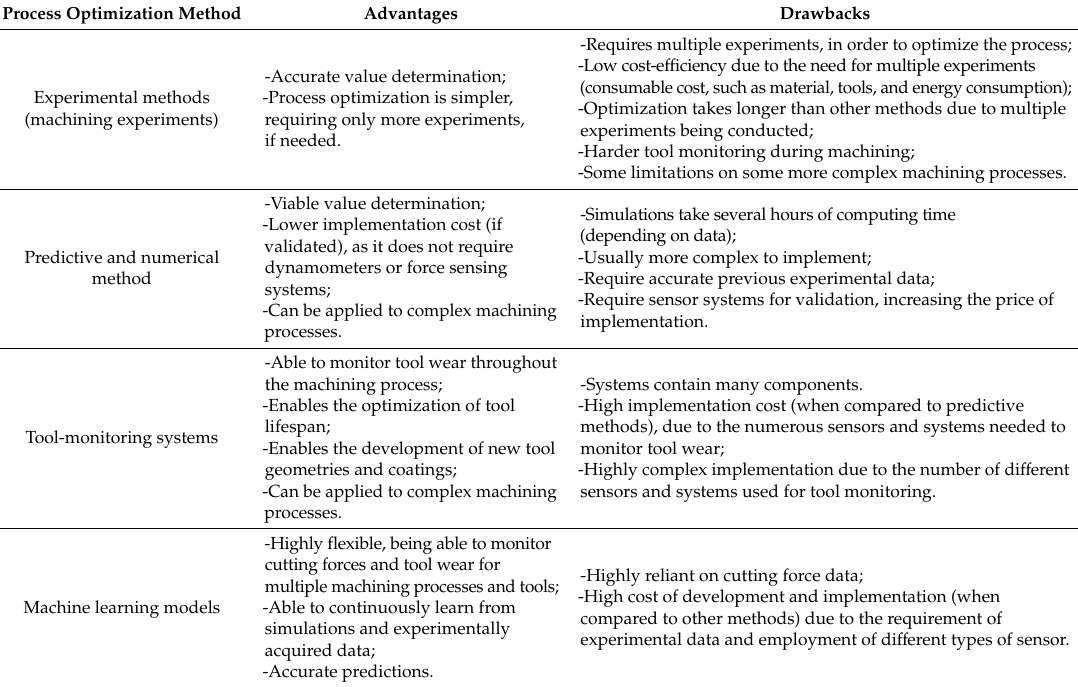
Table 3. Advantages and drawbacks of recently employed machining process optimization methods.